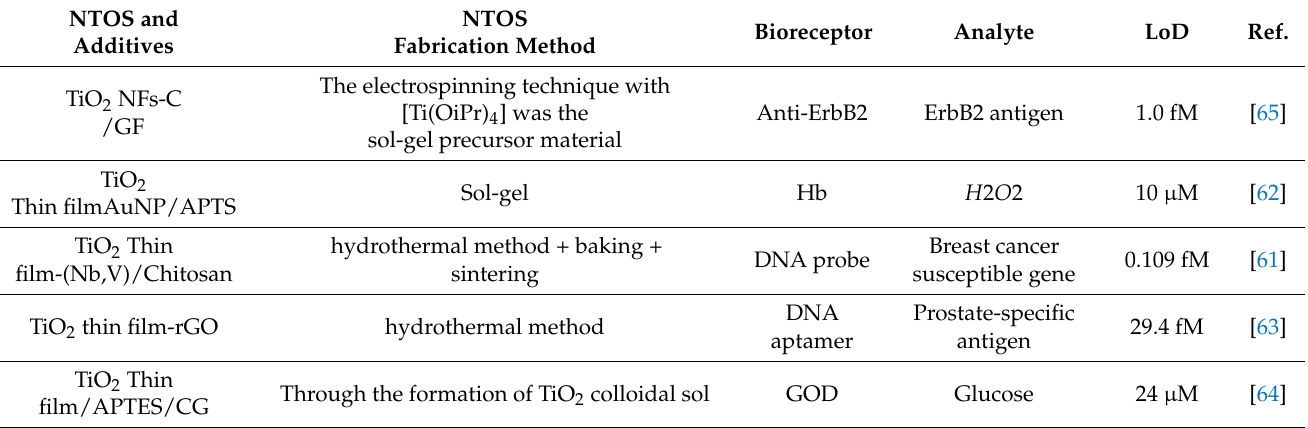
Table 3. Impedimetric biosensors based on